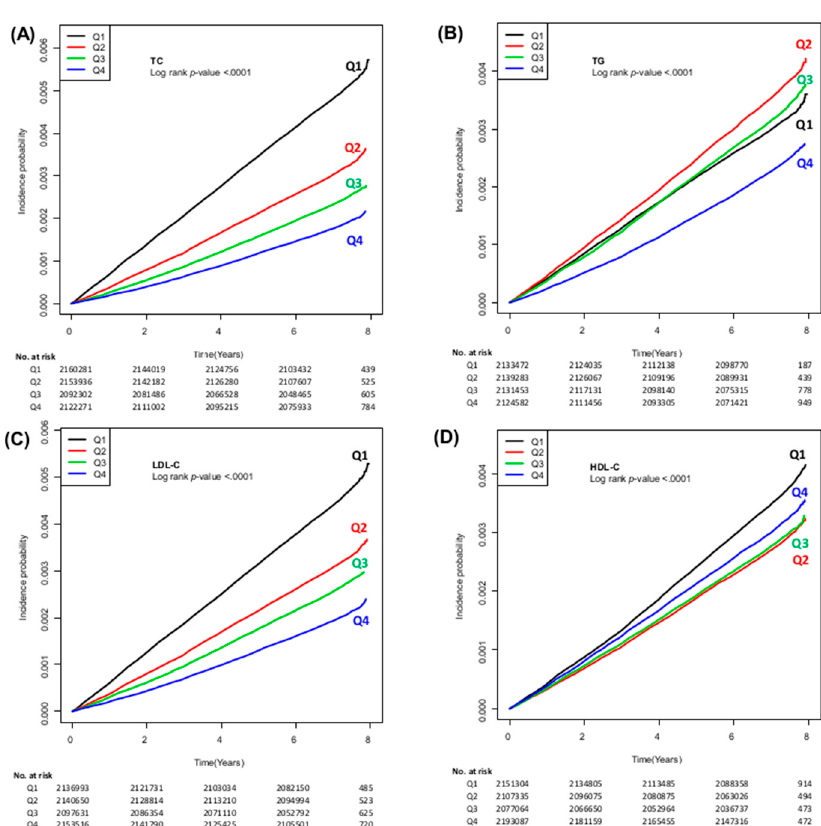
Figure 1. Cumulative incidence of HCC according to the quartiles of TC ( A ), TG ( B ), LDL-C ( C ), and HDL-C ( D ). HCC, hepatocellular carcinoma; TC, total cholesterol; TG, triglycerides; LDL-C, low-density lipoprotein cholesterol; HDL-C, high-density lipoprotein cholesterol.